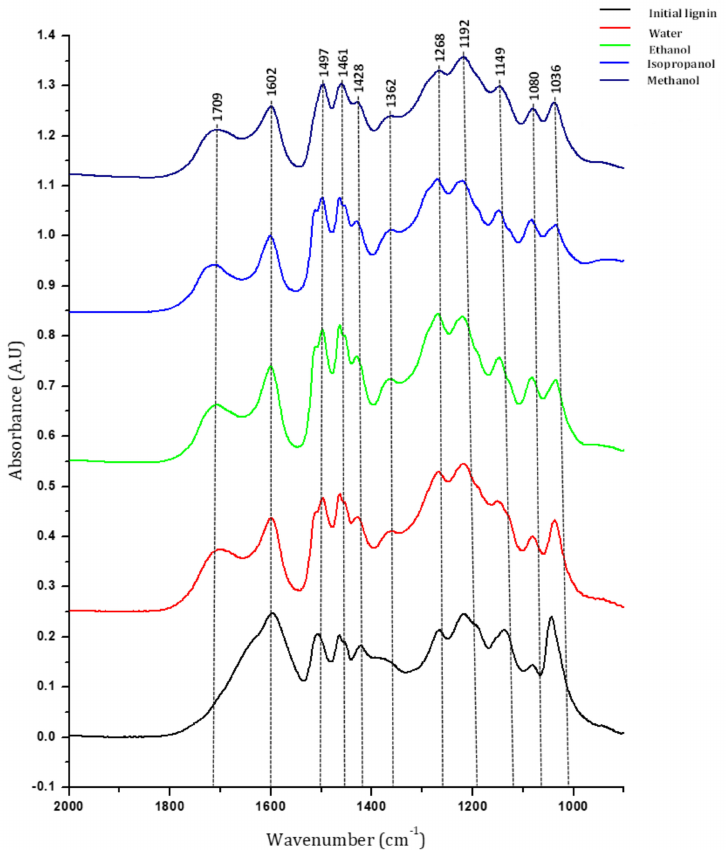
Figure 13. FT-IR spectrum of initial lignin and Klason phases after treatment in different water and water/alcohol mixtures.